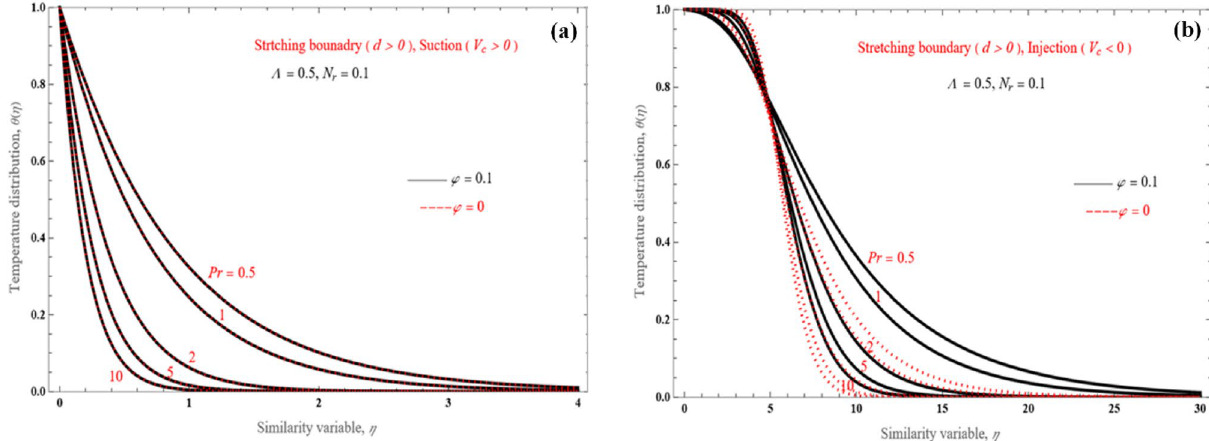
Figure 9. Temperature distribution for the ( a ) upper branch solution with suction and ( b ) lower branch solution with injection, for the shrinking sheet problem and various Pr values.